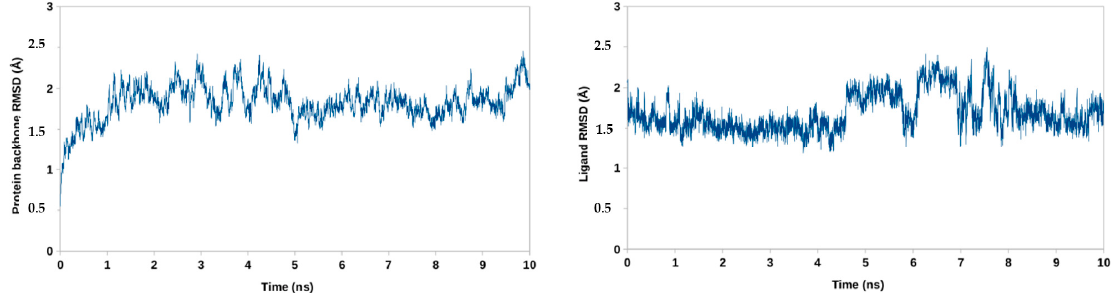
Figure 6. Root mean square deviation RMSD for atoms of CA-CTD-SP1 backbone (left) and BVM (right).